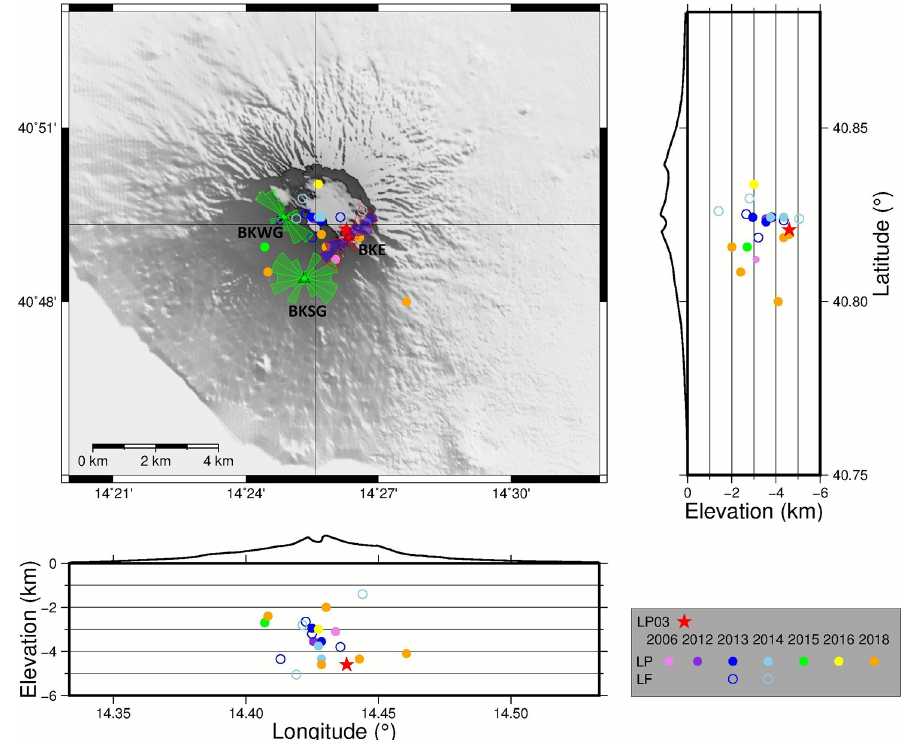
Figure 6. Hypocentral locations of the analysed earthquakes: LFs and LPs are represented by open and full circles, respectively. The rose plots of the polarization azimuth are superimposed to the seismic stations used for the analysis: for BKE the blue and red sectors are associated with the distribution of LFs and LPs, respectively. Red star indicates the location of LP03. For the other locations, the colorscale is from violet to orange in chronological order.